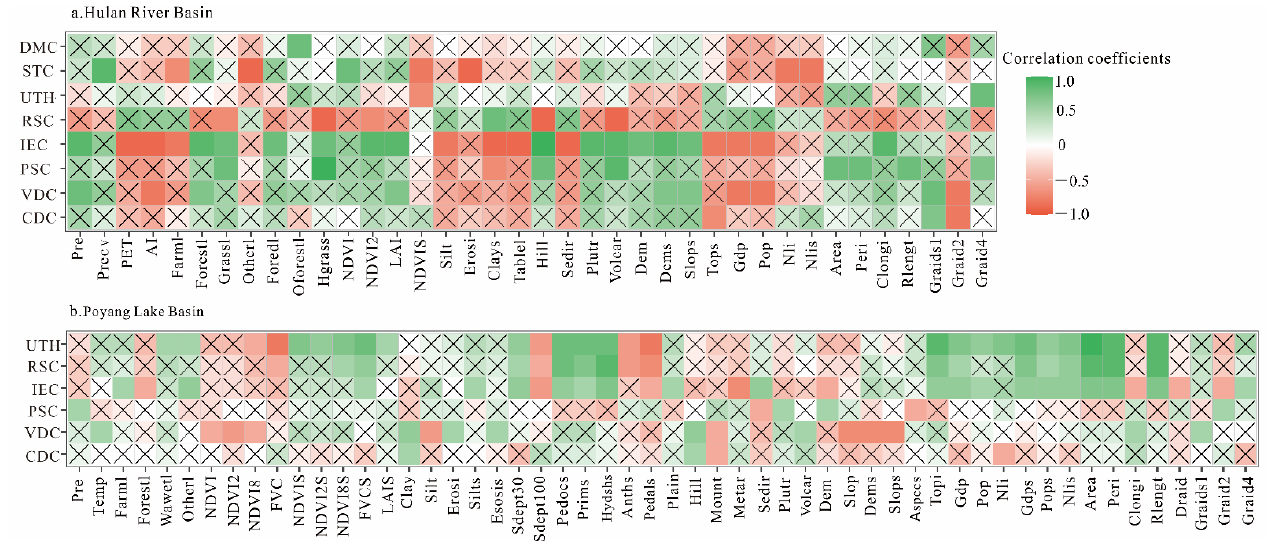
Figure 7. Correlation coefficients of model simulation efficiency (CDC for calibration period, VDC for validation period), hydrological model parameters, and indices of climate and underlying surface for the Hulan River Basin ( a ) and Poyang Lake Basin ( b ).